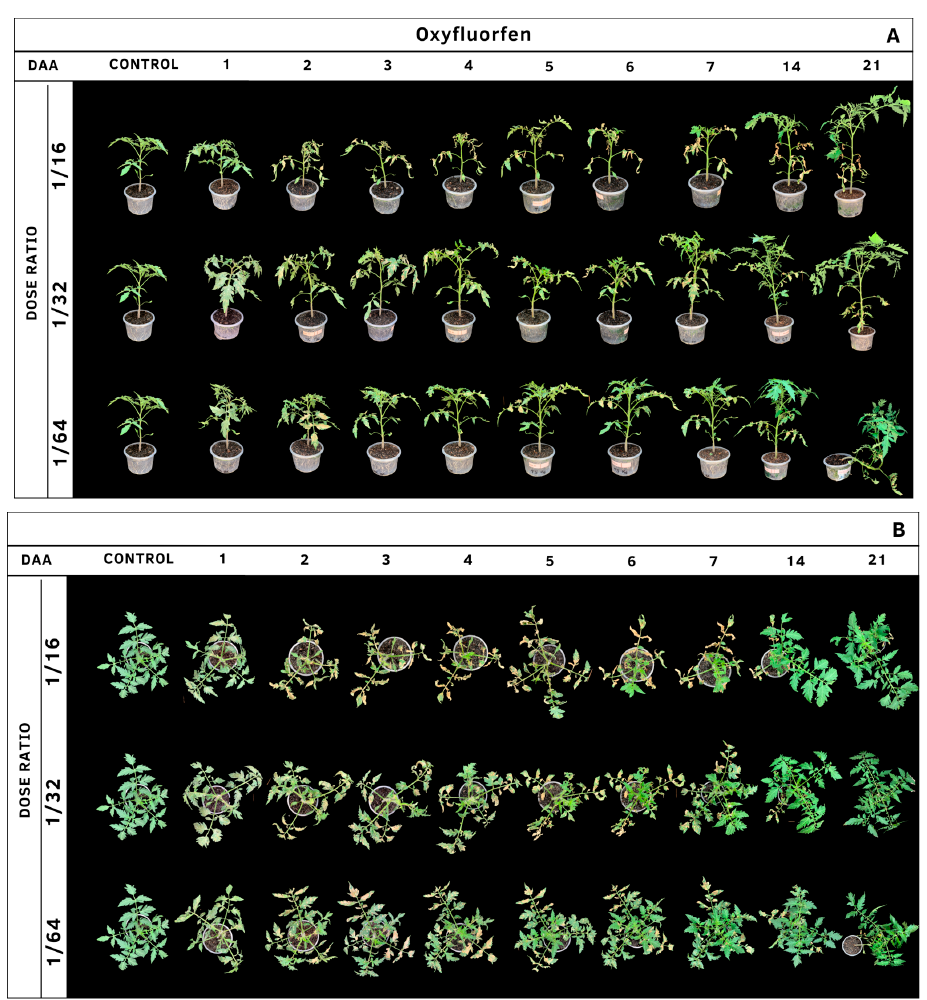
Figure 9. Symptoms evolution in tomato plants due to simulated oxyfluorfen drift at dose ratios 1/16D, 1/32D, and 1/64D (90, 45, and 22.5 g a.i. ha − 1 , respectively) of the recommended dose (D). Evaluations were made from 1 to 7, 14, and 21 days after application (DAA). Front view ( A ) and top view ( B ) of tomato plants affected by simulated